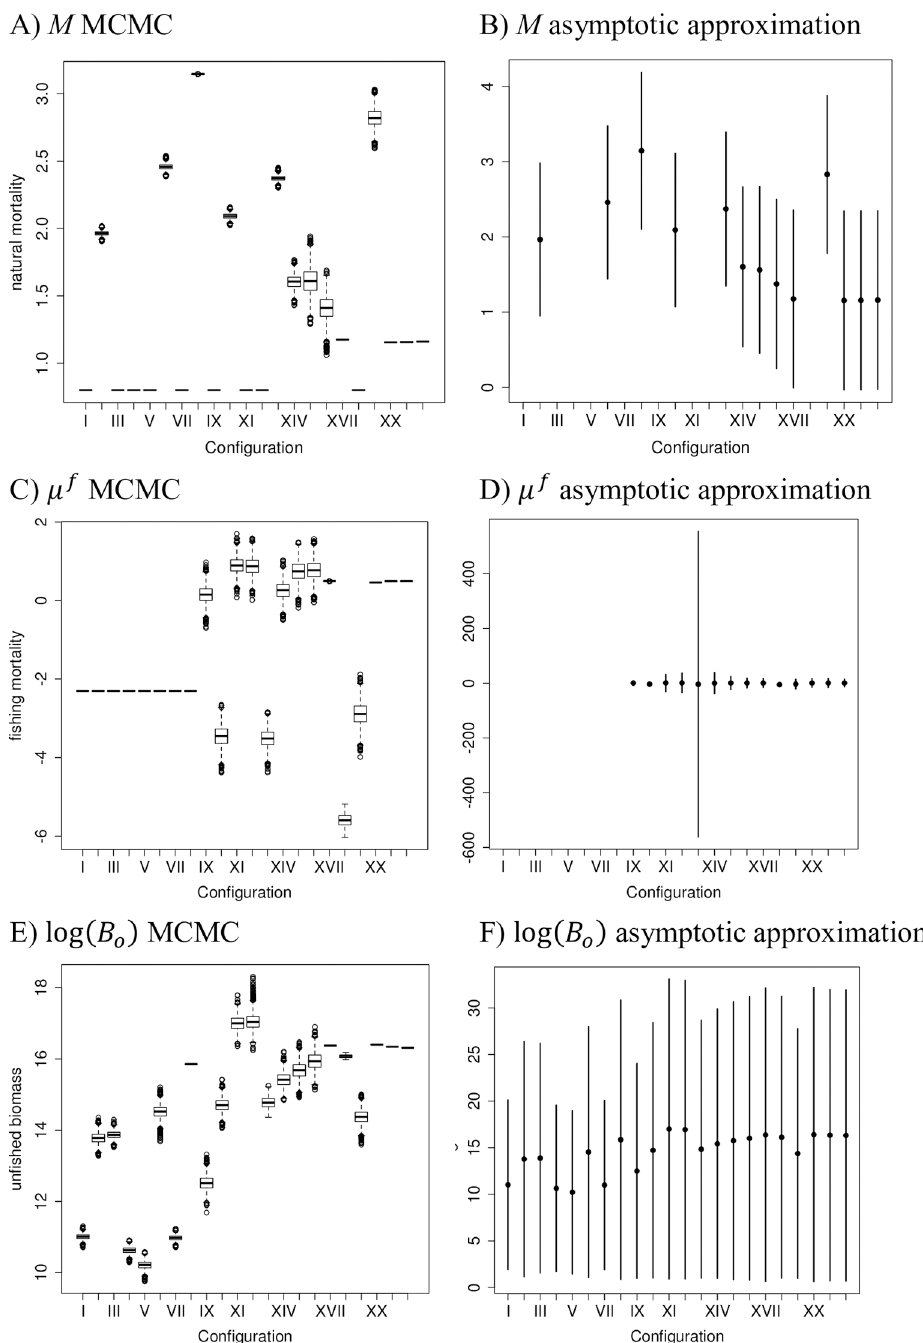
Fig 6. Parameter estimates and uncertainty ranges for natural mortality ( M ), mean fishing mortality ( μ f ) and unfished biomass ( B 0 ) from 22 model configurations. Boxplots of MCMC distributions, and 95% CIs based on MLE asymptotic approximation around MLE point estimates. A) M MCMC, B) M asymptotic approximation, C) μ f